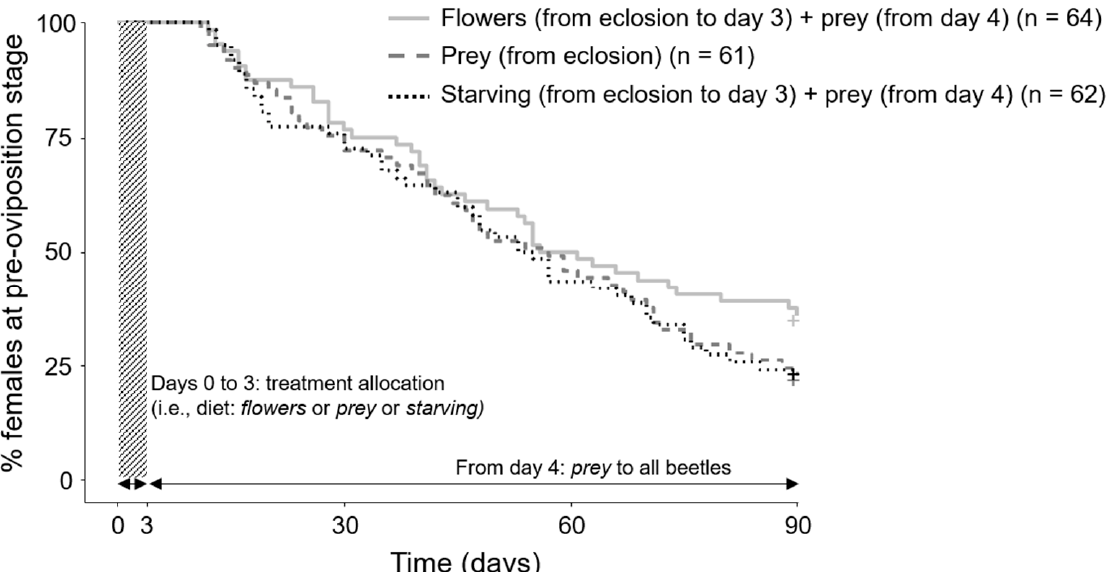
Figure 1. Kaplan–Meier curves showing the percentage of Harmonia axyridis females at pre-oviposition stage through time according to their diet (i.e., flowers, prey, or starving; diet offered over the first three days after eclosion, then all fed with Ephestia kuehniella eggs) plotted using the R package “survival” [43]. All the tested females were included in the analysis (including those that did not lay eggs at 90 days after emergence). Table 2. Effect of pre-oviposition time, diet (flowers, prey, or starving), and their interaction on the rate of viable egg batches (degree of freedom ( df ), chi-square value ( χ ² ) and p-value ( P ) from the likelihood-test for generalized linear models (GLM) are provided, *** p < 0.001).